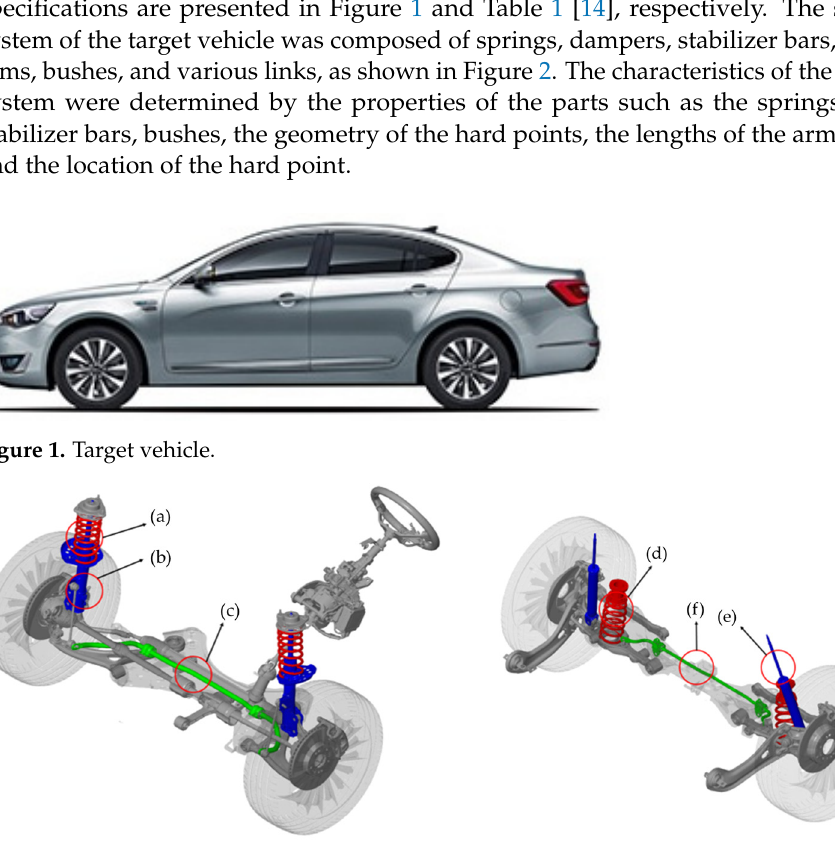
Figure 2. Suspension major parts: (a) front spring, (b) front damper, (c) front stabilizer bar, (d) rear spring, (e) rear damper, (f) rear stabilizer.